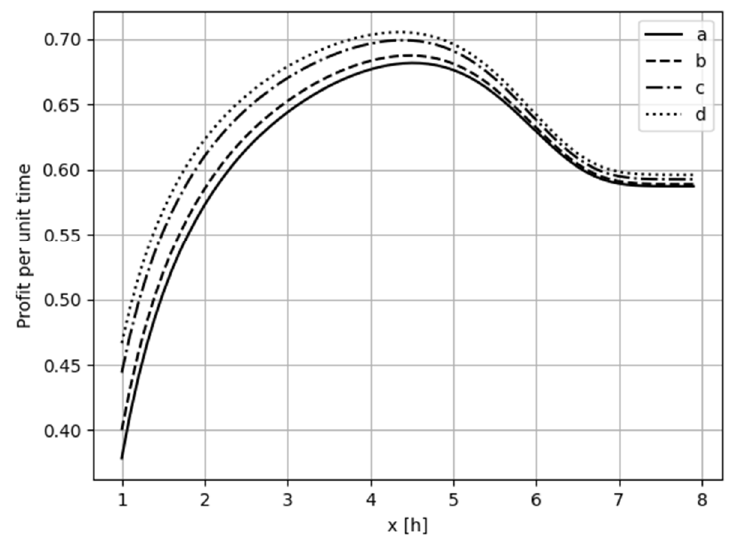
Figure 4. Graphs of the function g(x)—profit per time unit as a function of time to preventive replacement x [h], determined when the number of preventive replacements is as in the Example 1 (curve a) and when the number of preventive replacements is increased by 15%, 30% and 45%, respectively (curves b, c and d).